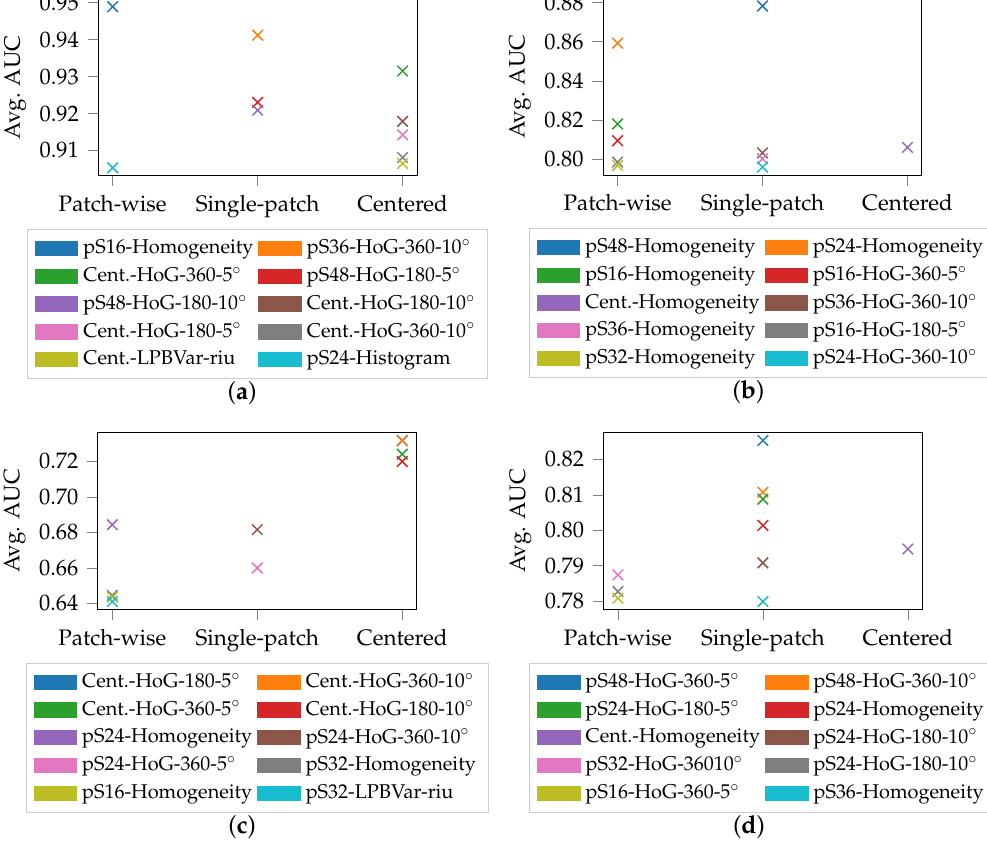
Figure 12. Average AUC of S245-equibiaxial strain: ( a ) DX54D (2.00 mm). ( b ) DP800. ( c ) DX54D (0.75 mm). ( d )